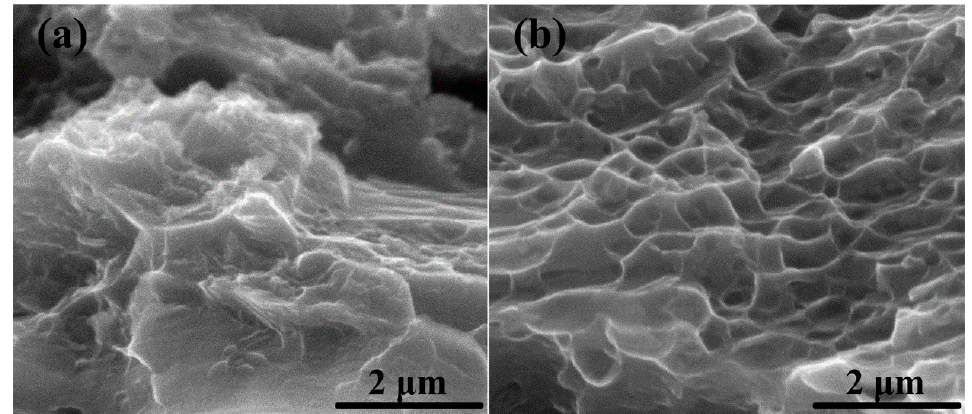
Figure 8. Fracture surfaces of: ( a ) extruded AT81; and ( b ) 0.5 vol % n-SiC p /AT81 composites reinforced by pre-oxidized (1073 K/2 h) n-SiC p .